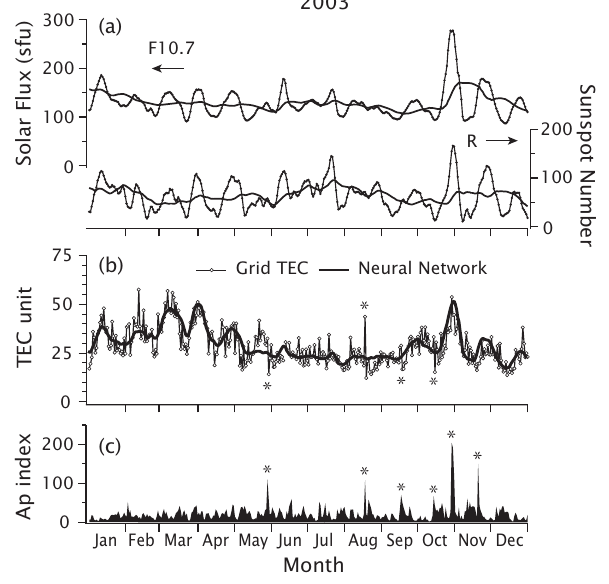
Fig. 9. (a) Solar activity variation of three-day mean (dots con- nected with line) and 81-day mean (solid lines) for 2003. (b) Com- parison of TEC predicted by NN and gTEC at grid number 14 (35 ◦ N, 137 ◦ E), 12:00 LT. (c) Ap index. The Ap index was not incorporated into the input parameter.